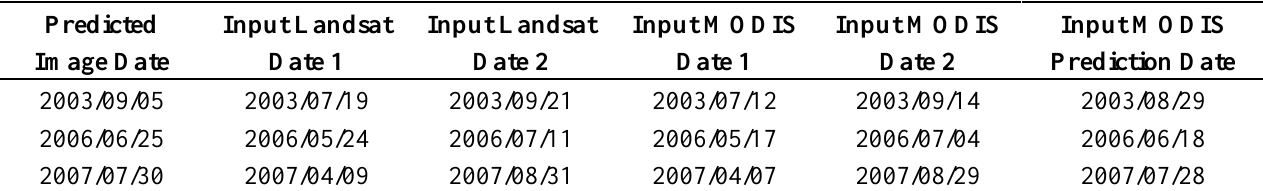
Table 3. Description of input images used to predict Landsat images used for accuracy assessment